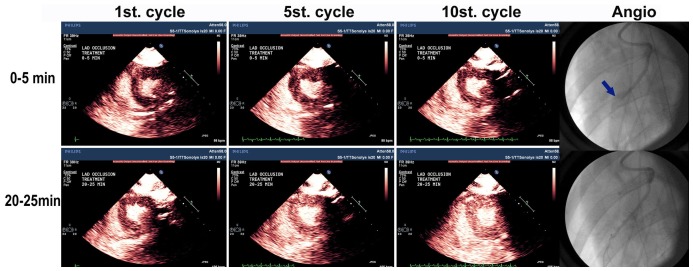
Intra-myocardial Passive Cavitation Detector Recordings During Therapeutic Impulses.Passive cavitation detector recordings from the anterior myocardium during a continuous infusion of microbubbles and application of the long pulse duration 1.0 MI (left panel) and short pulse 2.0 MI (right panel) therapeutic impulses. The black dots above the baseline signal represent inertial cavitational activity, which disappeared when the left anterior descending was occluded (The “TUS On” following balloon inflation), confirming that recorded activity was intra-myocardial. Note that the amplitude of the voltage, and number of recorded events produced by the cavitational spikes were similar for the two different therapeutic impulses. However, since the 20 usec pulse lasts four times longer than the 5 usec pulse, the aggregate cavitational activity for the 20 usec pulse is nearly four times longer (0.73 volt-seconds versus 0.22 volt-seconds).